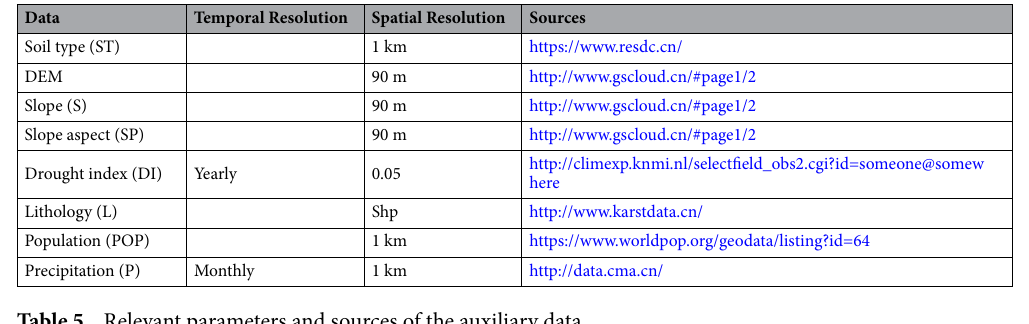
Table 5. Relevant parameters and sources of the auxiliary data.